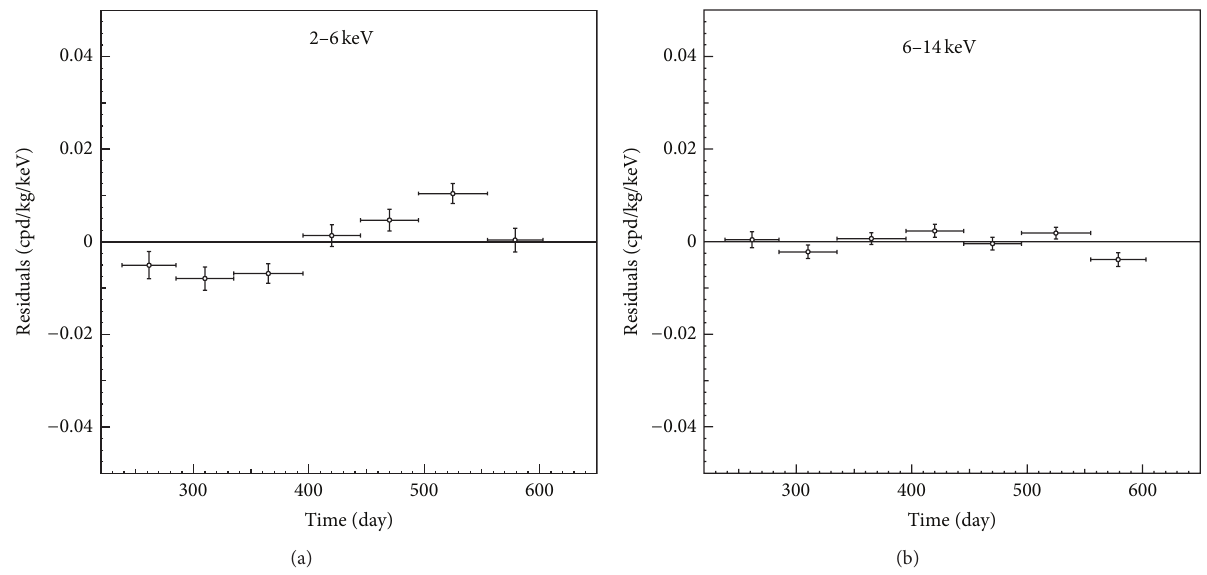
Figure 3: Experimental single-hit residuals in the (2–6)keV and in the (6–14)keV energy regions for the entire DAMA/LIBRA-phase1 data as if they were collected in a single annual cycle (i.e., binning in the variable time from the Jan 1st of each annual cycle). The data points present the experimental errors as vertical bars and the associated time bin width as horizontal bars. The initial time of the figures is taken at August 7th. A clear modulation satisfying all the peculiarities of the DM annual modulation signature is present in the lowest energy interval with 𝐴 = (0.0088 ± 0.0013) cpd/kg/keV, while it is absent just above 𝐴 = (0.00032 ± 0.00076) cpd/kg/keV.